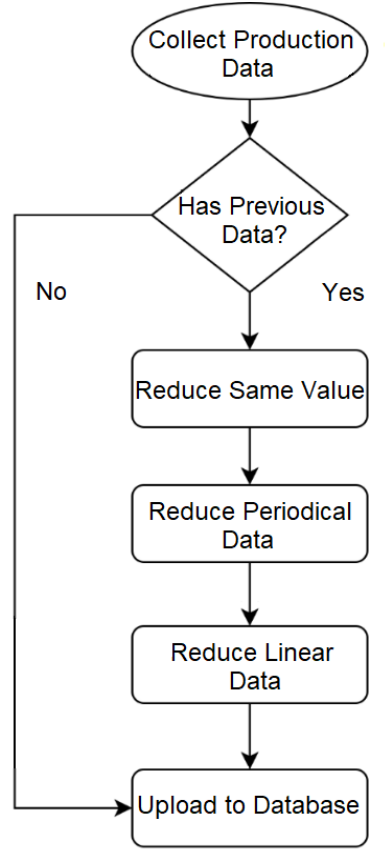
Figure 1. Reducing data transmission flowchart.